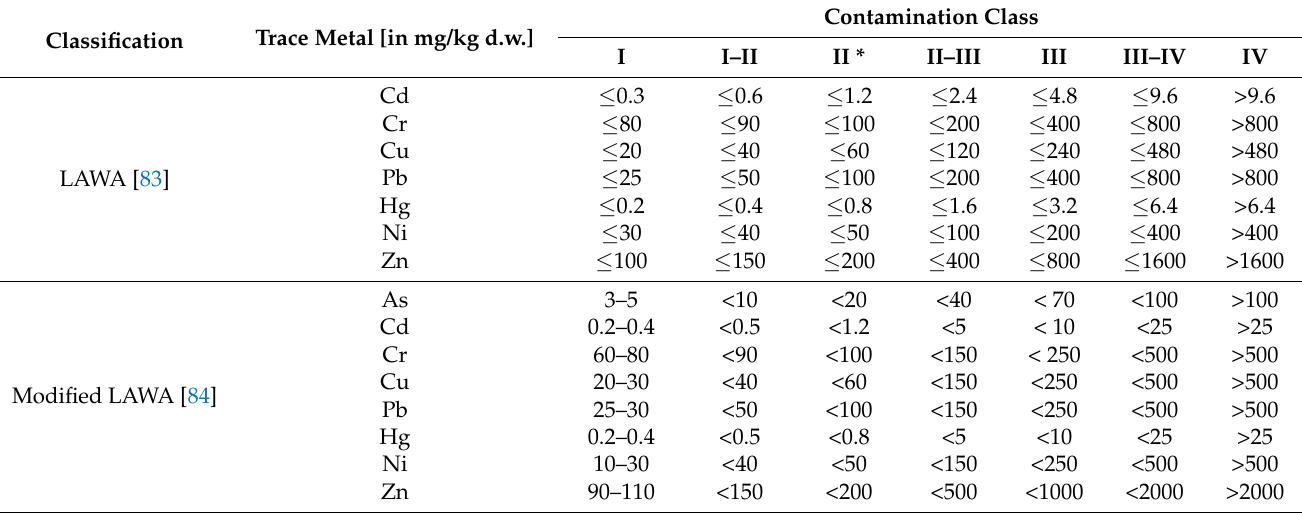
Table 3. The concentration of various trace metals (TMs) in mg/kg d.w. for each class of sediments—classification LAWA and modified LAWA [83,84]. Trace Metal [in mg/kg